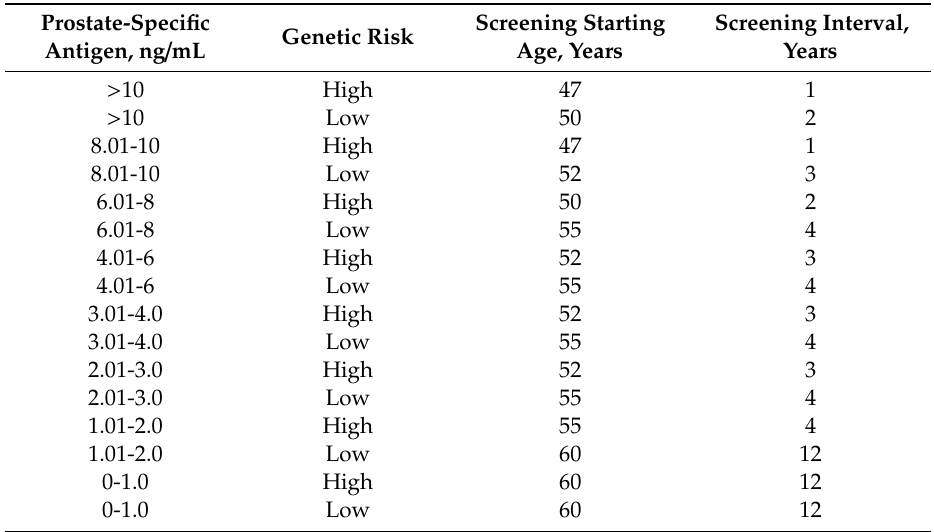
Table 3. The recommended age to start screening and the screening interval by PSA level and combined genetic risk among subjects susceptible to progressive PCa. Prostate-Specific Screening Starting Screening Interval, Genetic Risk Antigen, ng / mL Age, Years Years